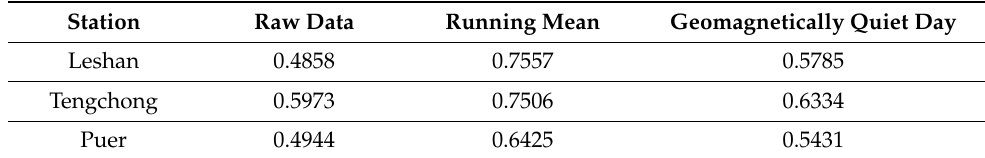
Table 3. Correlation coefficient between CSES and ionosonde Ne for Leshan, Tengchong and Puer stations in different